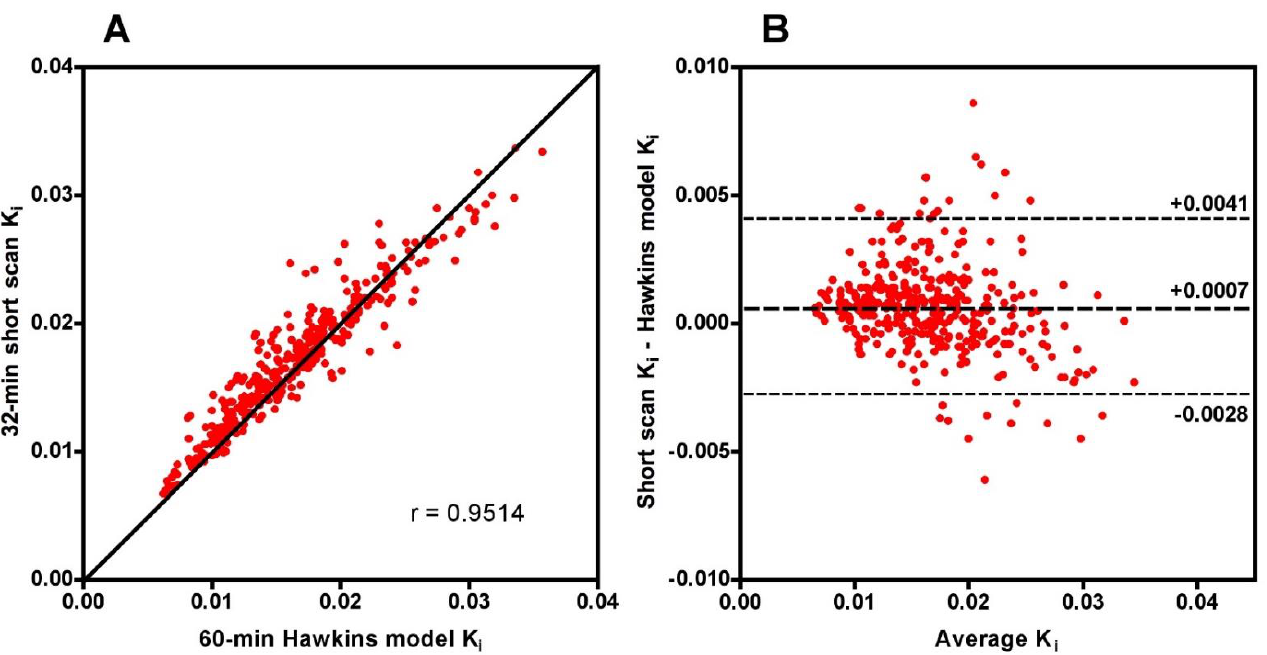
Figure A1. ( A ) Scatter and ( B ) Bland-Altman plots of the 32-min short-scan K i and the 60-min Hawkins model values for the data plotted in Figure 3. The 378 data points in each plot were derived from 54 PET scans (27 baseline and 27 follow-up scans) with 7 volumes of interest analysed on each scan.